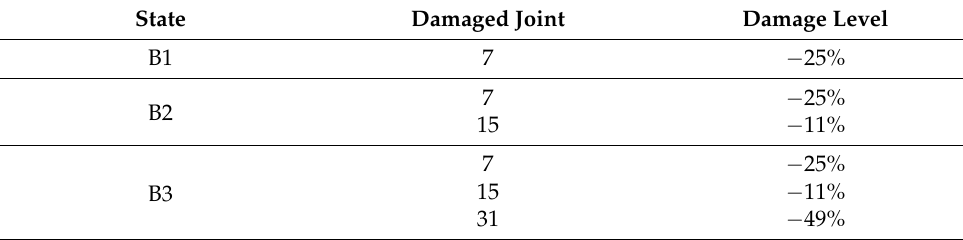
Table 4. Test case